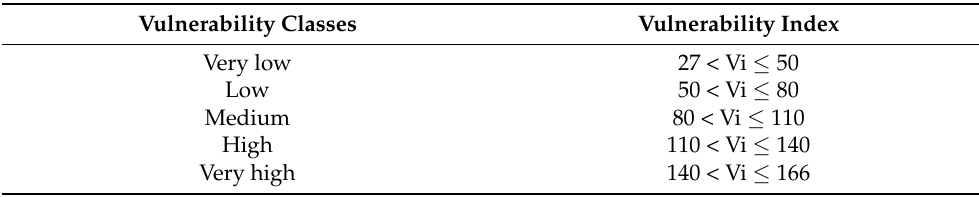
Table 2. DRSTI vulnerability index classification